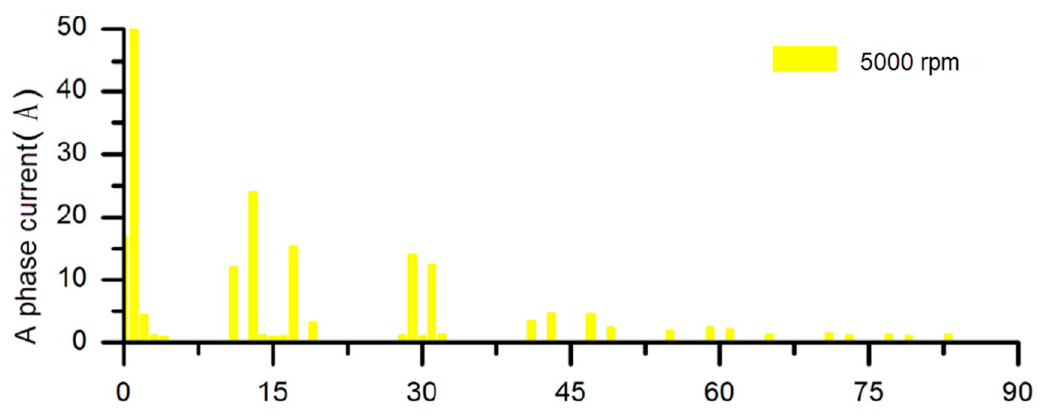
ff erent harmonic orders at 5000 rpm.